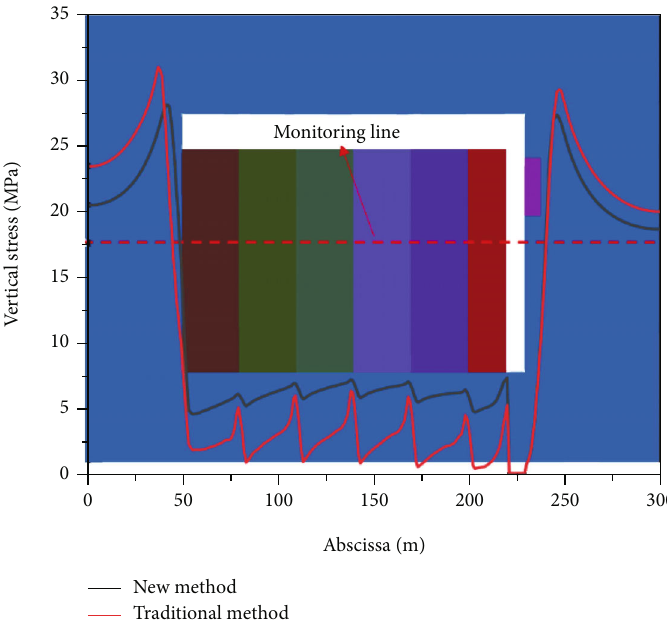
Figure 8: Stress distribution characteristics of goaf.